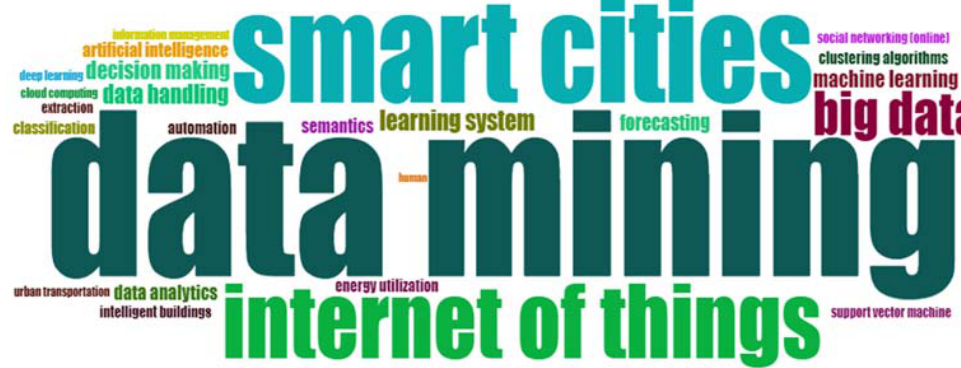
Figure 10. Word cloud.